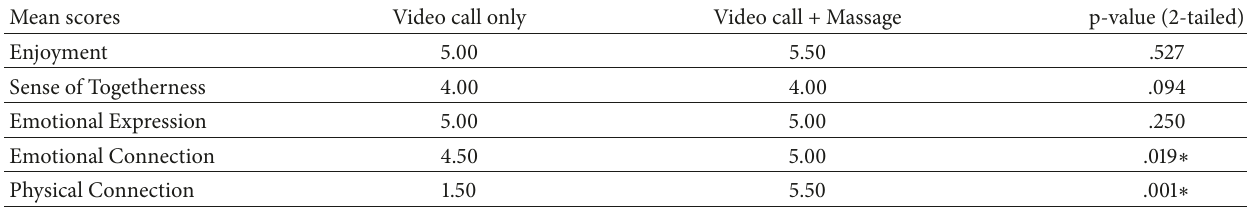
Table 4: Median ratings for subjective perception of the communication